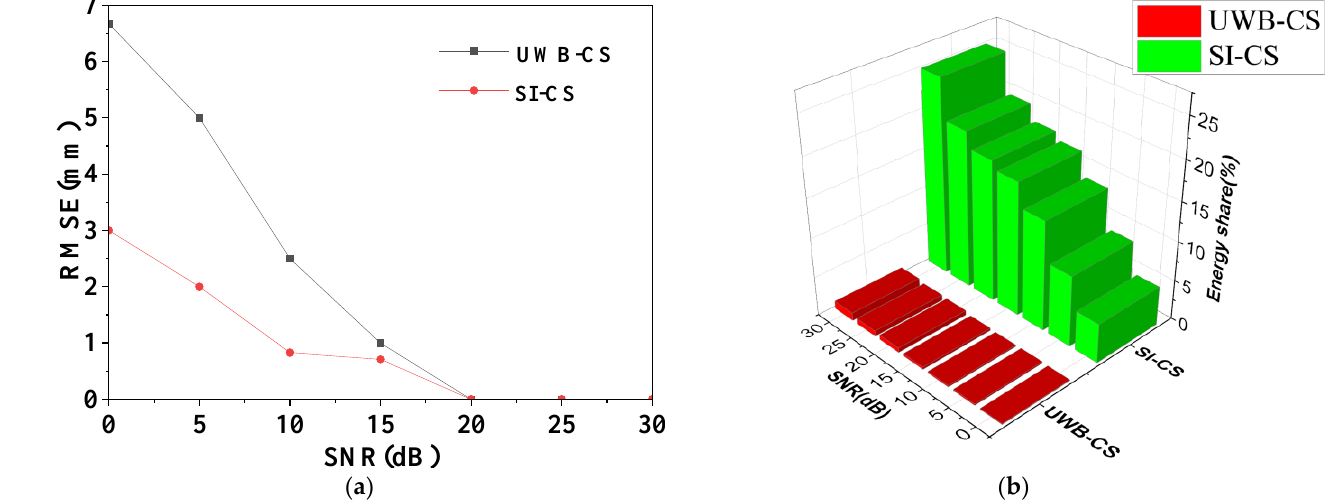
Figure 7. ( a ) The RMSEs of the UWB-CS method and the SI-CS method. ( b ) The energy share of the UWB-CS method and the SI-CS method.